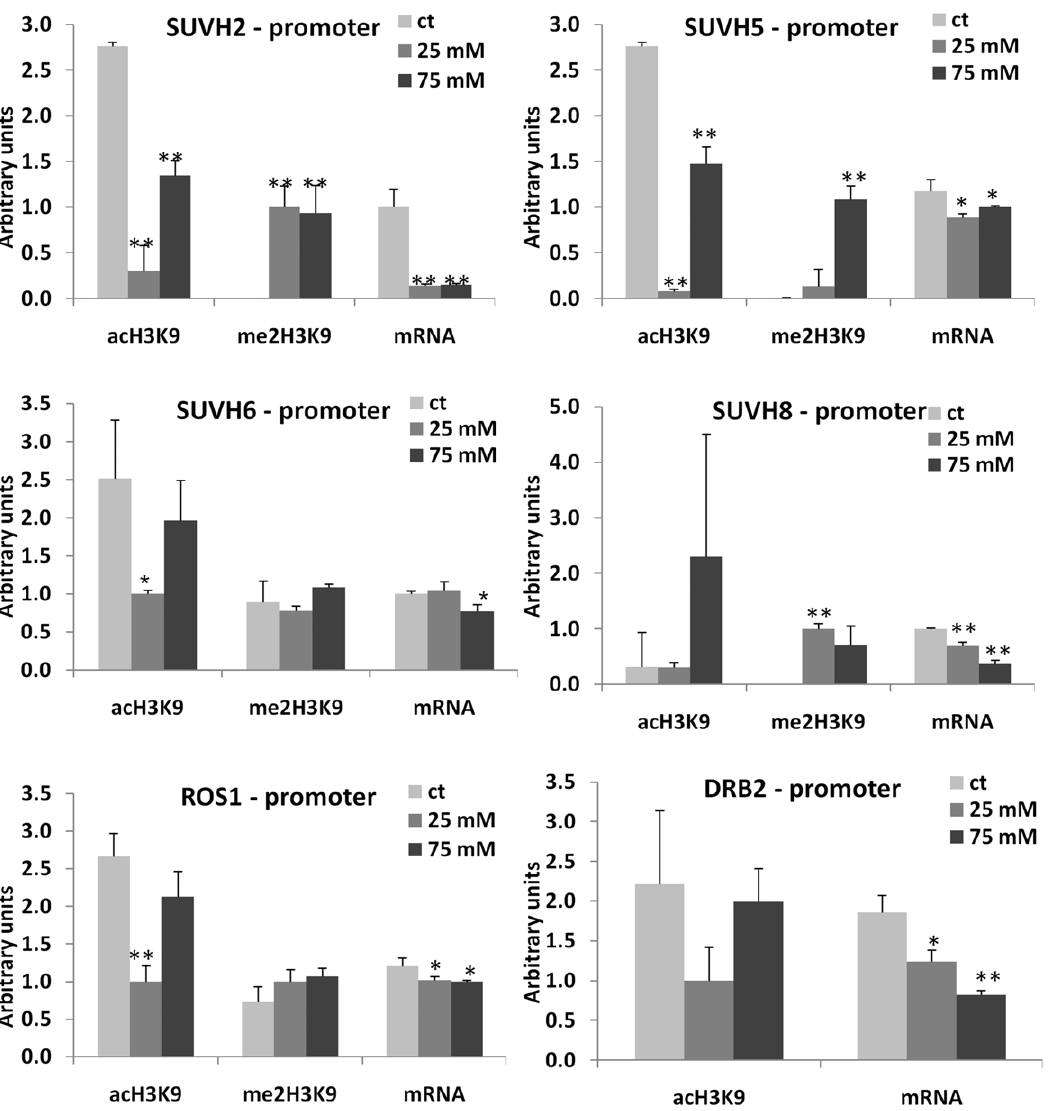
Figure 4. Histone modifications (H3K9me2 and H3K9ac) at the promoter regions of SUVH2 , SUVH5 , SUVH6 , SUVH8 , ROS1 and DRB2 genes. The figure shows the levels of H3K9me2 and H3K9ac observed at the promoter region of SUVH2 , SUVH5 , SUVH6 , SUVH8 , ROS1 and DRB2 genes. Each figure also shows mRNA levels for each of the genes. The Y-axis shows the levels of mRNA expression and H3K9me2/H3K9ac in average arbitrary units (calculated from three independent experiments with SD). The asterisks denote a significant difference between the progeny of stressed (25 and 75 mM) and control plants; one asterisk stands for p , 0.05 and two asterisks for p , 0.01.